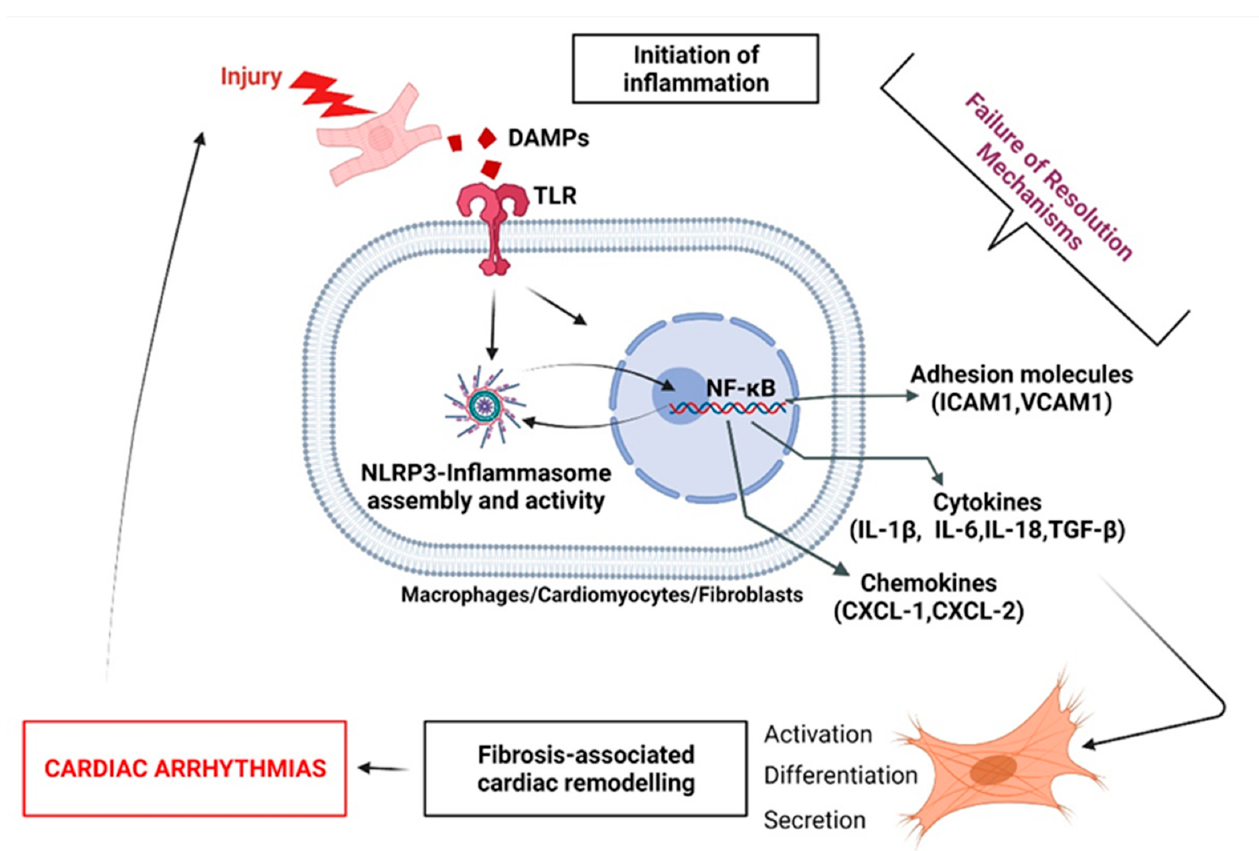
Figure 7. The central role of unresolved fibroblasts-associated inflammatory status in the develop- ment of arrhythmogenic cardiac fibrosis. During acute inflammation, the initiation of inflammation is normally followed by a resolution, in order to promote homeostasis. Failure in the activation of pro-resolving signals contributes to the exacerbation of cardiac cells’ release of proinflammatory stimuli. FB are highly sensitive to inflammatory agents. When activated, cardiac FB participate in increasing the production of inflammatory compounds, leading to the development of fibrosis, my- ocardial dysfunction and arrhythmogenicity.